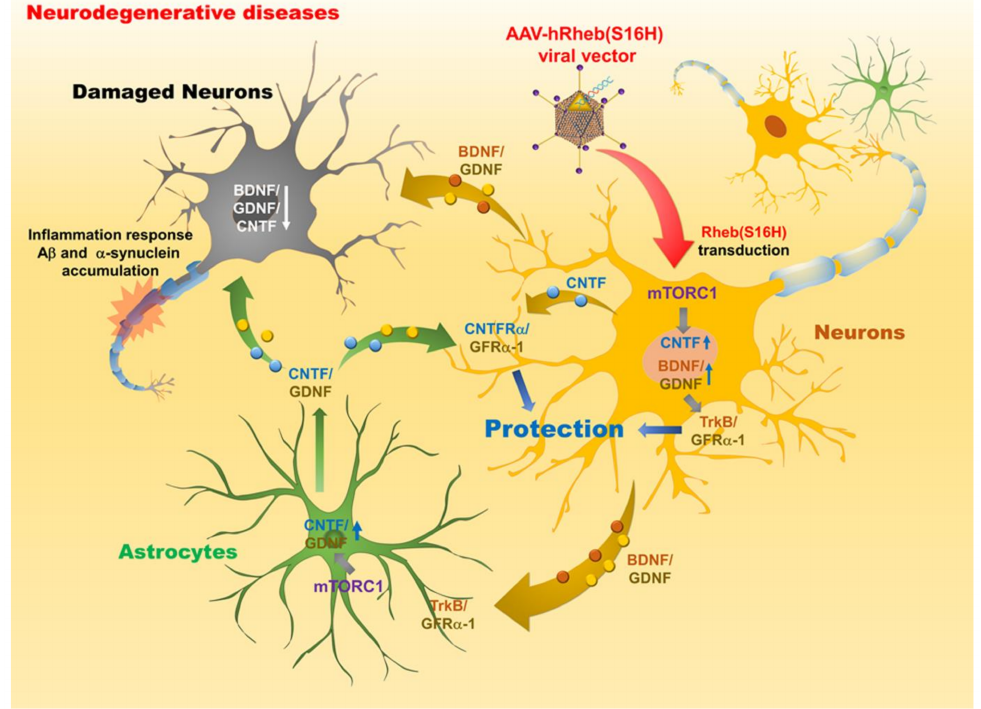
Figure 2. Schematic representation of the mechanisms of a neuroprotective system following AAV-hRheb(S16H) transduction in neurodegenerative diseases. In neurodegenerative diseases, various neurotoxicities, including A β deposition, α -synuclein aggregation, and inflammatory responses, induce axon loss and demyelination of specific neurons as well as reduction of neurotrophic factors (NTFs), leading to decreased memory/cognition and movement decline. hRheb(S16H) transduction of hippocampal or SNpc neurons using adeno-associated virus serotype 1 (AAV1) can induce the activation of mTORC1, which in turn stimulates the production of NTFs, such as brain-derived neurotrophic factor (BDNF), glial cell line-derived neurotrophic factor (GDNF), and ciliary neurotrophic factor (CNTF) in the neurons. Increased BDNF and GDNF expressions contribute to neuroprotection through the activation of TrkB/GFR α -1 receptor, in the hippocampus and SNpc of brain, respectively. Moreover, CNTF production by hRheb(S16H) expression in SNpc neurons mediates neuroprotective effects through the CNTFR α receptor. In addition, BDNF/GDNF expression induced in hRheb(S16H)-expressing neurons result in functional interactions between neurons and astrocytes in the hippocampus, leading to the production of astrocytic CNTF and GDNF for hippocampal